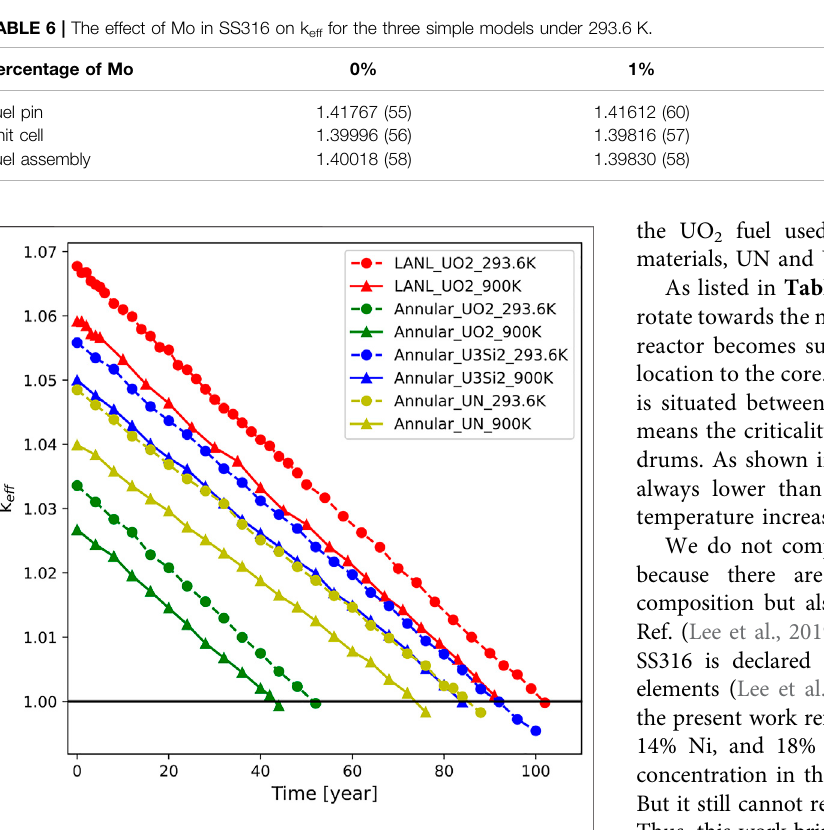
FIGURE 5 | Evolution of k eff for case A.